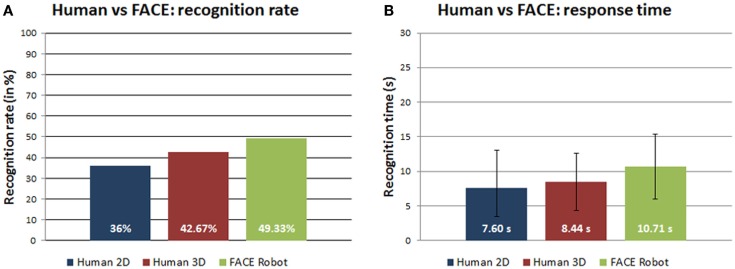
(A) Recognition rates (in percentage) and (B) response time (in seconds) of human 2D photos, human 3D models, and robot FACE expressions.